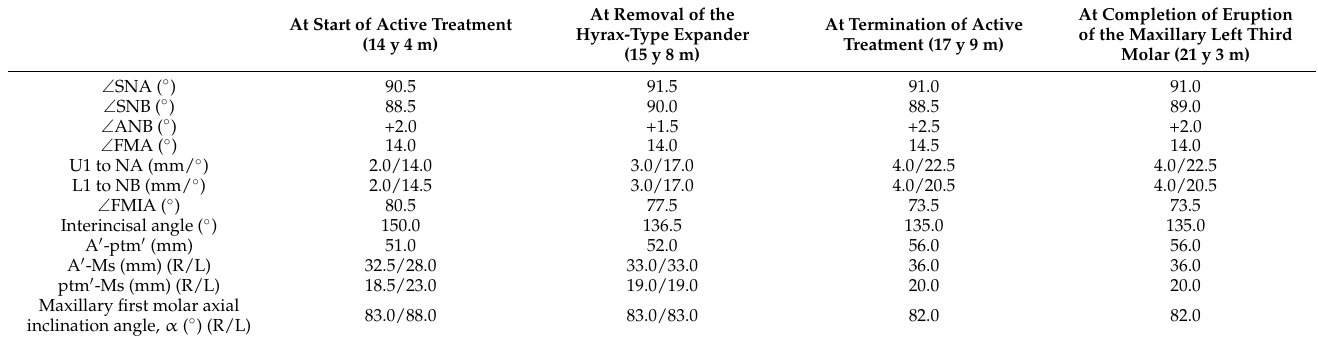
Table 1. Cephalometric